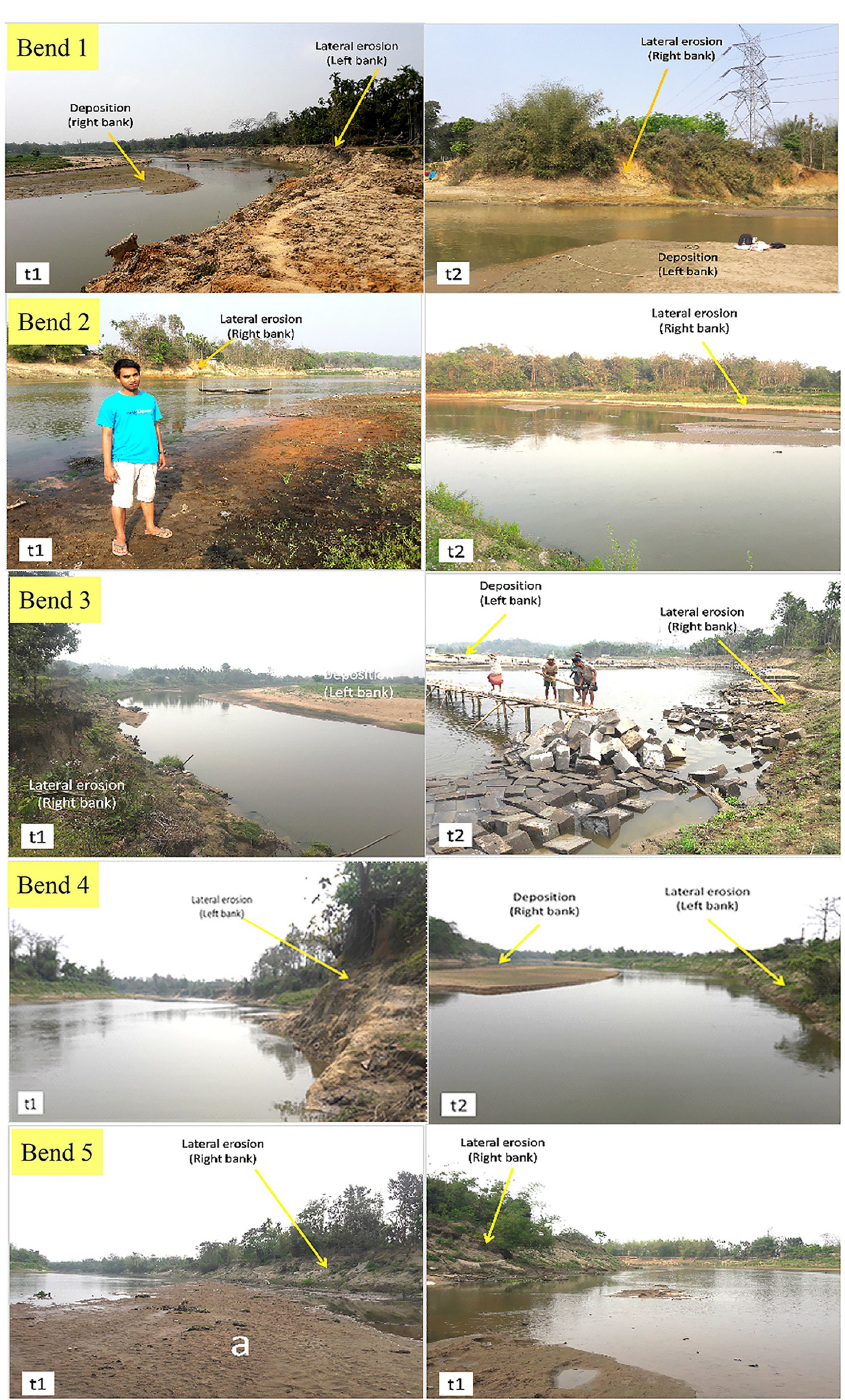
Fig 19. The present condition of banks of the five surveyed bends.